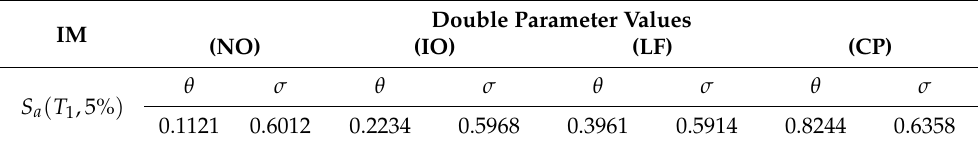
Table 8. Double parameter values of performance level at each limit state.